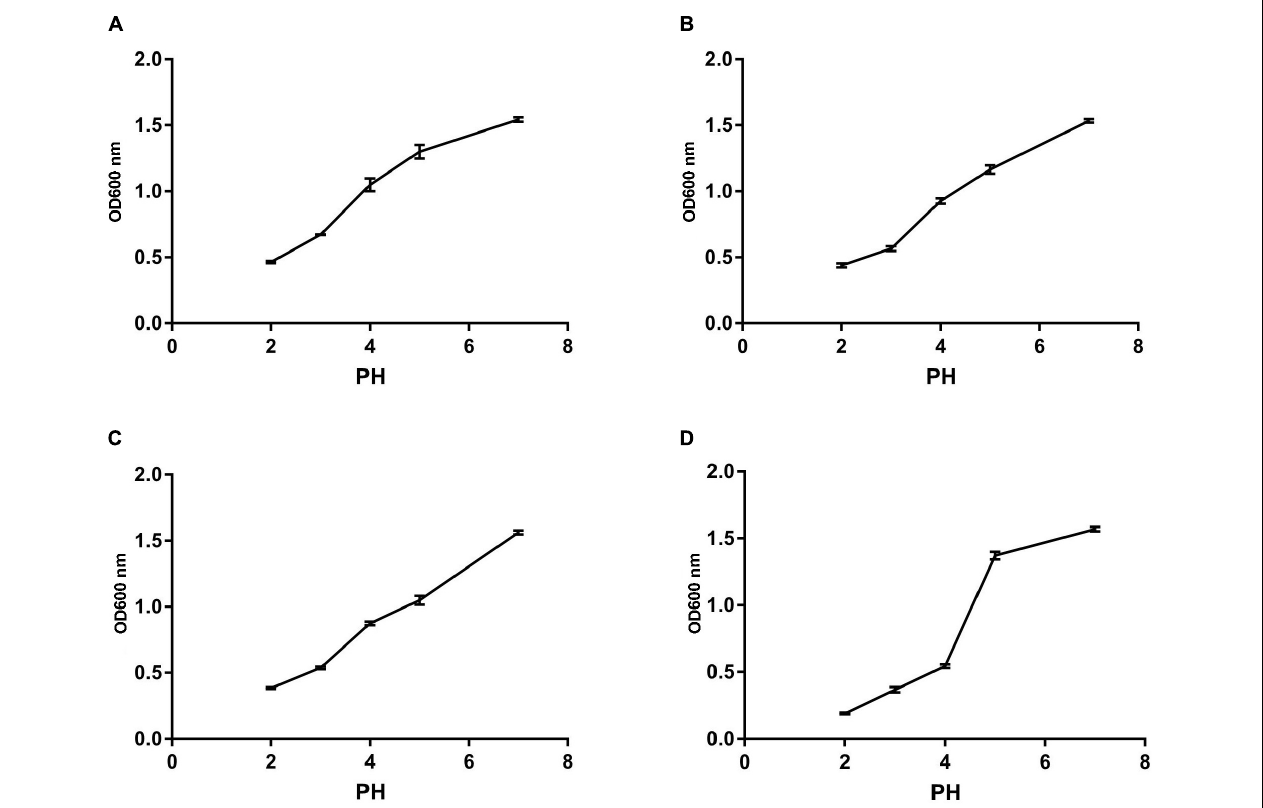
FIGURE 6 | The survival rate of different strains under different acid conditions. (A) The result determines tolerance to acid conditions of Z1. (B) The result determines tolerance to acid conditions of Z2. (C) The result determines tolerance to acid conditions of J. (D) The result determines tolerance to acid conditions of K.